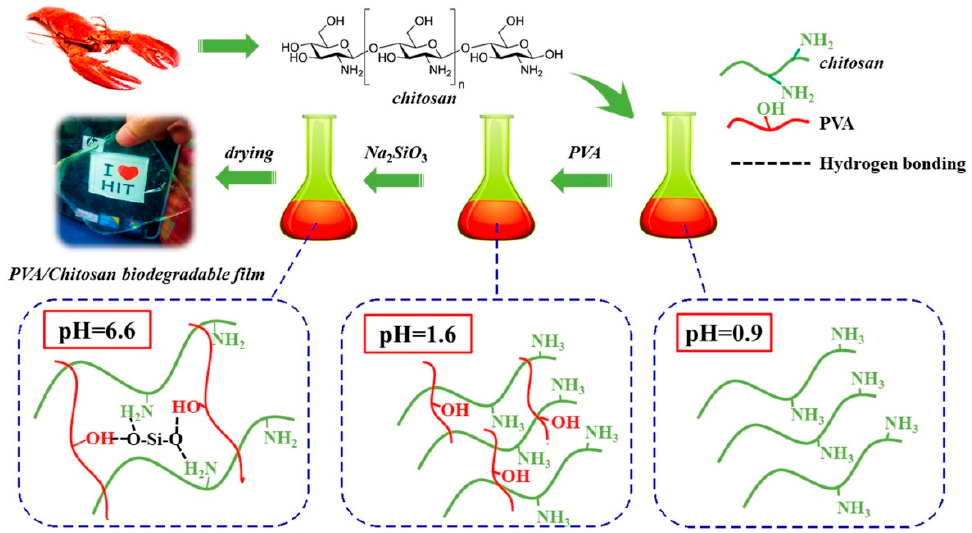
Figure 3. SiO 2 in situ enhanced PVA/CS biodegradable films by hydrolysis of sodium metasilicate [87].